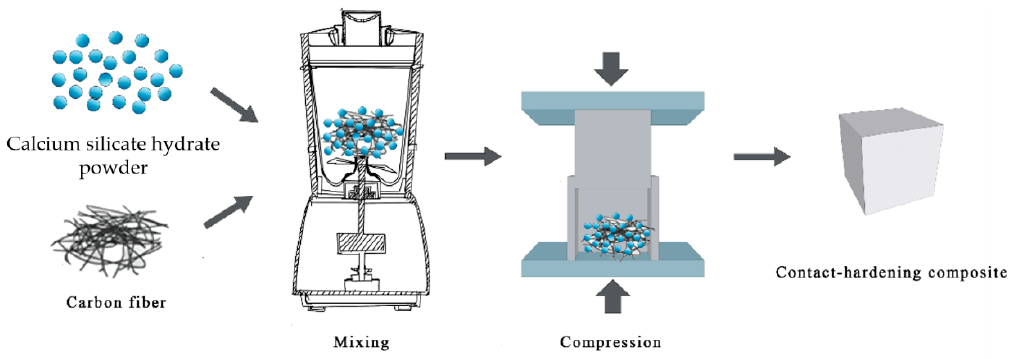
Figure 4. Flow chart of the preparation of the contact-hardening composites.